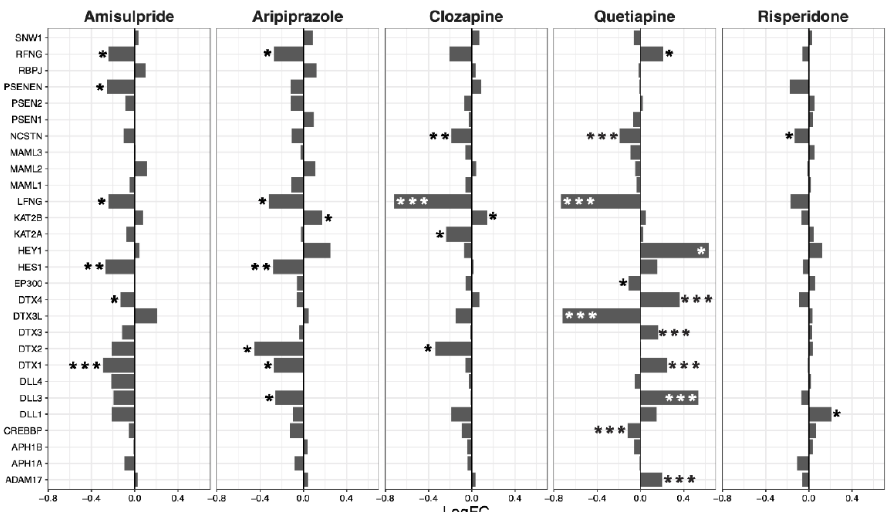
Figure 3. Notch signaling pathway genes regulated by psychotropic drug treatment in NT2-N cells expressed as log fold change relative to vehicle-treated cells. * p < 0.05, ** p < 0.005, and *** p < 0.001.